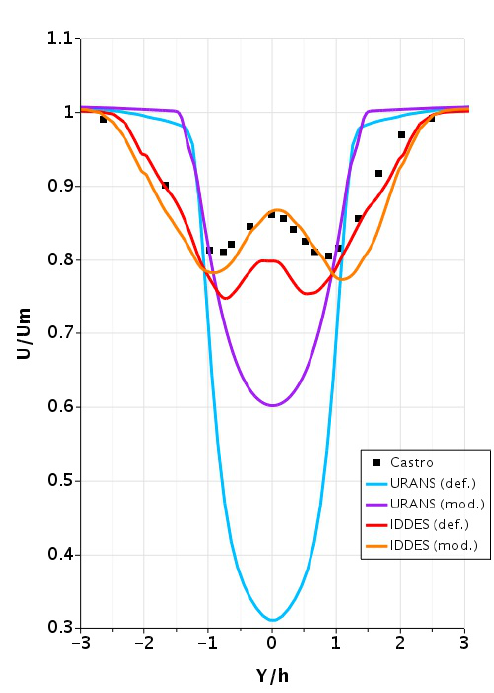
Figure 8. Comparison of Spanwise Mean Velocity along the Symmetry Plane at x / h = 2.0 and z / h = 0.5.